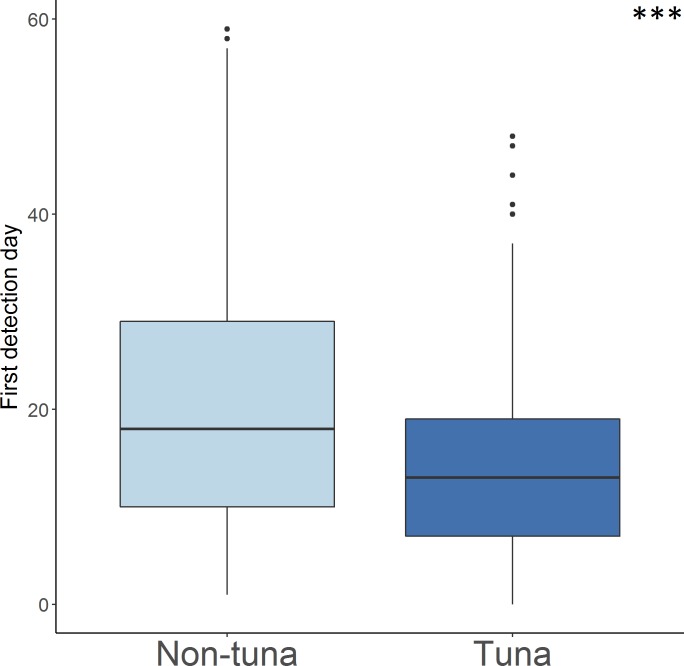
Boxplot of first detection day of tuna and non-tuna species to the object.Asterisks indicate the significance levels of differences following Mann-Whitney U test (* p < 0.05; ** p < 0.01; *** p < 0.001; NS not significant).